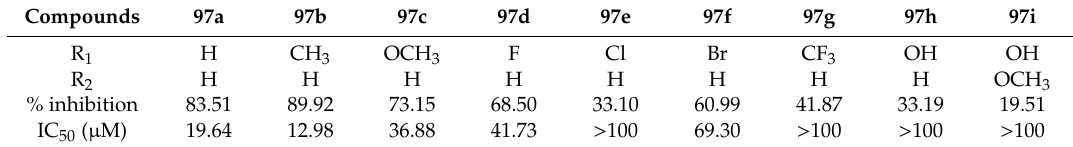
Table 15. Inhibitory Activity of Compounds 97a–i on α -glucosidase [69].